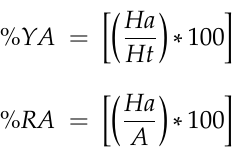
(Figure 6) (LVs 1, r 2 ext_ts = 0.421; LVs 2, r 2 ext_ts = 0.698; LVs 3, r 2 ext_ts = 0.657; LVs 4, r 2 ext_ts = 0.712; LVs 5, r 2 ext_ts = 0.735; LVs 6, r 2 ext_ts = 0.787; Figures S1–S6,